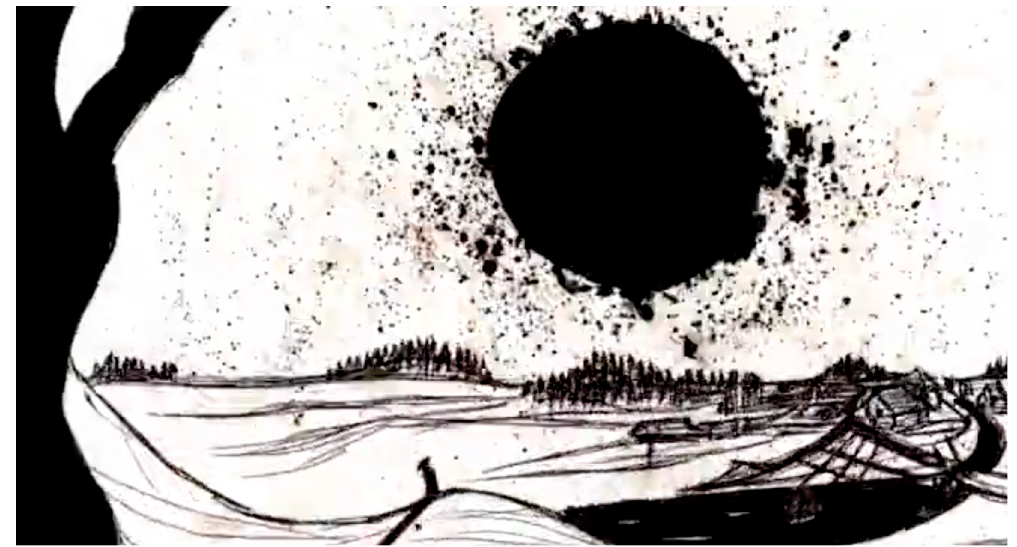
Figure 1. A black sun burns. Frame capture, The Pride of Strathmoor (Baldvin 2014).